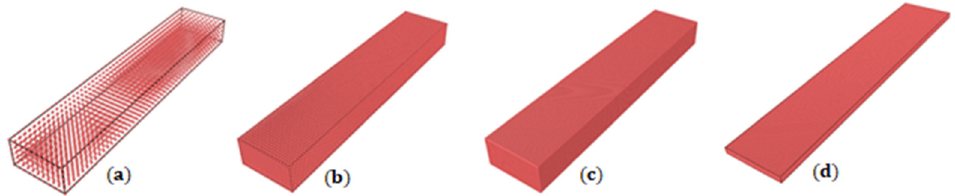
Figure 7. Geometries of bitumen for tensile tests. ( a ) 3D, l = 10 − 3 m; ( b ) 3D, l = 5 × 10 − 4 m; ( c ) 3D, l = 2 × 10 − 4 m; ( d ) example of a thin plate, l = 2 × 10 − 4 m.